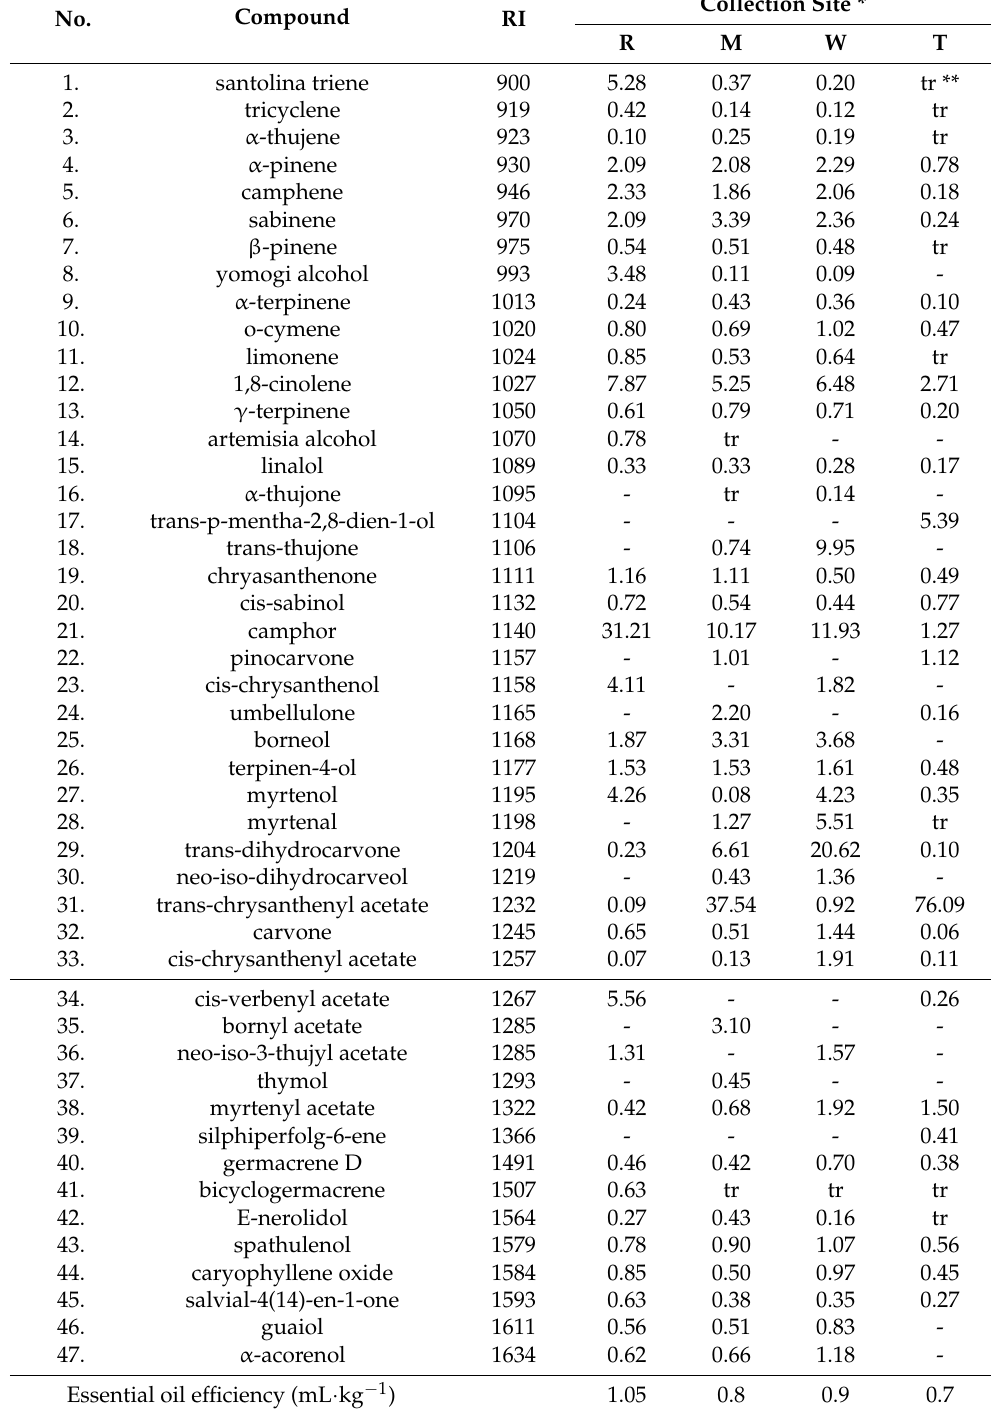
Table 4. Essential oil composition of wild-growing tansy plants